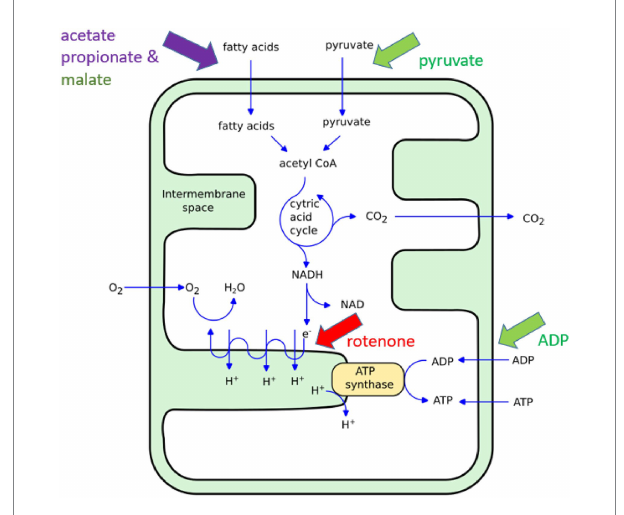
FIGURE 1 Illustration of the ATP synthesis in mitochondria. The chemicals used in this study induce an increase (green), a reduction (red) or more complex (violet) effects on mitochondria metabolism. For more detailed information on the specific effects of short chain fatty acids on mitochondrial function see (MacFabe, 2015; Frye et al.,